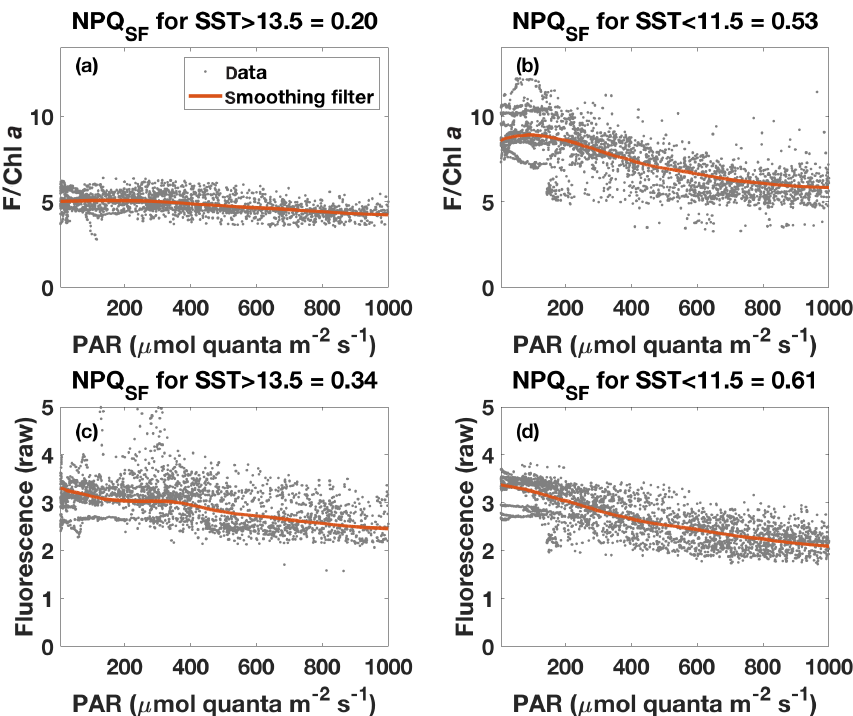
Figure 8. Fluorescence–PAR relationship as in Fig. 7 but with data grouped according to the respective SST (grey dots) and with a robust loess smoothing filter applied to the ordered data (red). Note that data for PAR < 5µmolquantam − 2 s − 1 are not shown. Panels (a) and (b) show the results for fluorescence normalized to Chl a (estimated based on ac-9 data), while panels (c) and (d) show results for unnormalized fluorescence. NPQ SF was calculated according to Eq. (6) using the smoothed data, with F max the maximum fluorescence for PAR > 5 and PAR < 1000µmolquantam − 2 s − 1 , while F min was taken as the minimum fluorescence for that